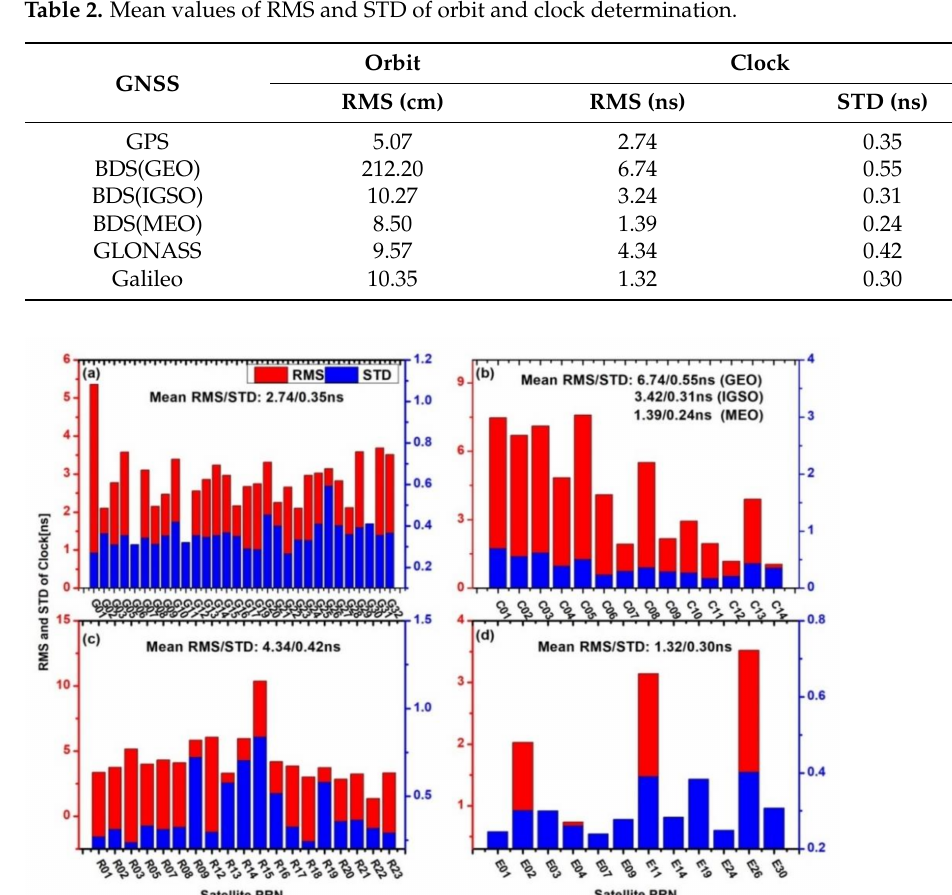
Figure 4. Average RMS and STD values real-time calculation compared with GFZ final products for DOY 346 to 349, 2019. ( a ) GPS; ( b ) BDS; ( c ) GLONASS; ( d )